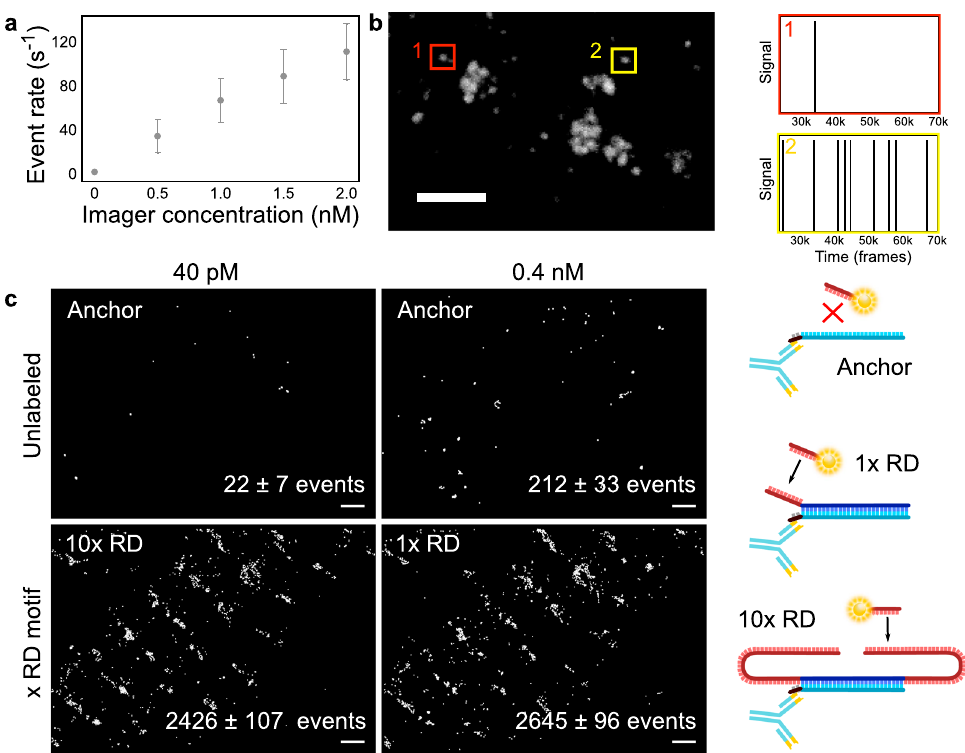
Fig. 3 Repeat DNA-PAINT reduces non-speci fi c imager binding. a : Rate of non-speci fi c binding events of P1 imagers in unlabeled cardiac tissue as a function of [ I ], displaying a linear trend. Error bars show the SD around the mean of the number of binding events per second, ( n = 200). b : DNA-PAINT image of RyRs obtained using the protocol in Fig. 1c and rendering only the 1x RD events. Time traces of typical 1x RD showing suspected non-speci fi c (1) and speci fi c events (2) from the regions highlighted. Similar event kinetics observed across n = 5 repetitions in biological tissue. c : A visual example of the levels of non-speci fi c binding present in a typical experiment. First, tissue was imaged with [ I ] = 40 pM and 0.4 nM when only anchor sites were present in order to obtain the rates of non-speci fi c events. Once the anchor strands were functionalized with 1x RD (and [ I ] = 0.4 nM) or 10x RD (and [ I ] = 40 pM), event rates are comparable, suggesting that 1x RD signals contain ~8% non-speci fi c events whilst 10x RD signals have only ~0.9% contribution from non- speci fi c events. Similar levels of non-speci fi c events observed in n = 3 comparable repetitions. Scale bars: b 500 nm, c 1 µ